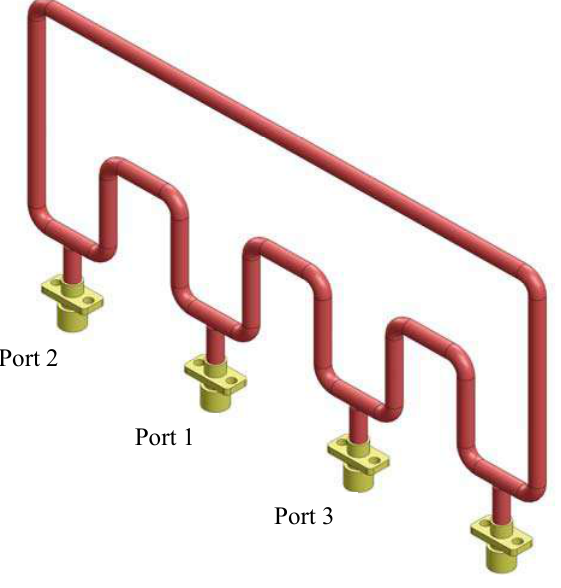
Fig.3: Isometric view of Rat-Race coupler